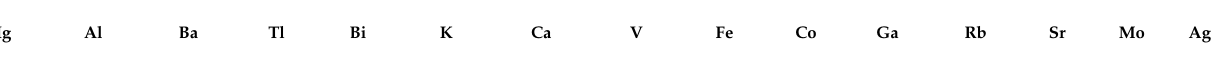
Table 4. Correlation matrixes of selected heavy metals in rainwater harvesting cisterns (n =